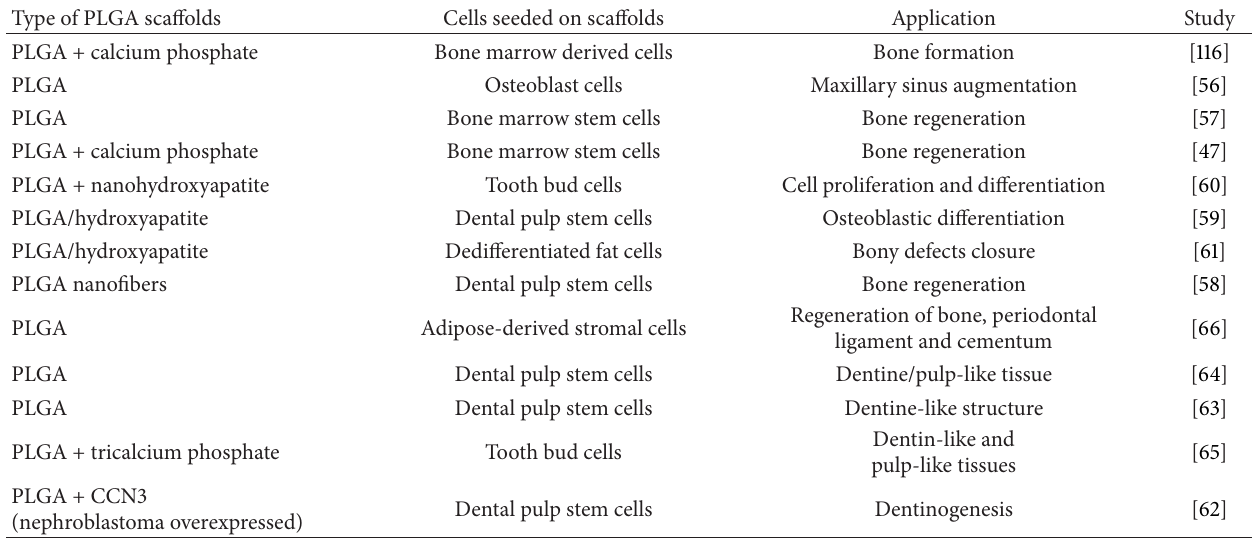
Table 3: Applications of PLGA scaffolds in regenerative